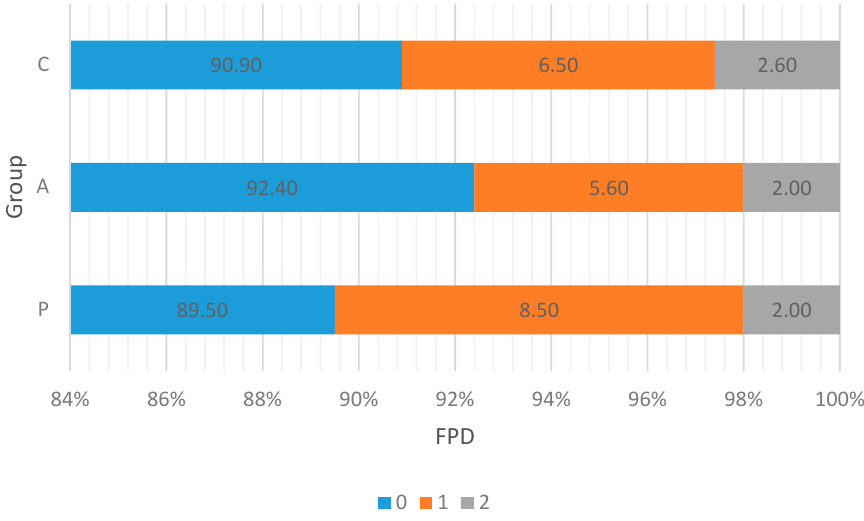
Figure 2. The occurrence of foot pad dermatitis in broiler chickens (%). Birds were fed a non- supplemented control diet (C); the control diet supplemented (in addition) with a phytogenic supplement containing hop (A); or the control diet supplemented with organic acids and their salts and prebiotic complex mixed in the proportion of 65/30 v/v, respectively ( P ). A gait score of 0 represented a lower frequency of foot pad dermatitis occurrence, whereas 2 represented a higher frequency of footpad dermatitis occurrence. The variance between groups did not differ significantly, p = 0.275. For the studied groups, the median was 0, which means that over half of the birds were evaluated as 0. Mean ± SD; C = 0.12 ± 0.393; A = 0.1 ± 0.393; P = 0.13 ± 0.387. All birds were evaluated.